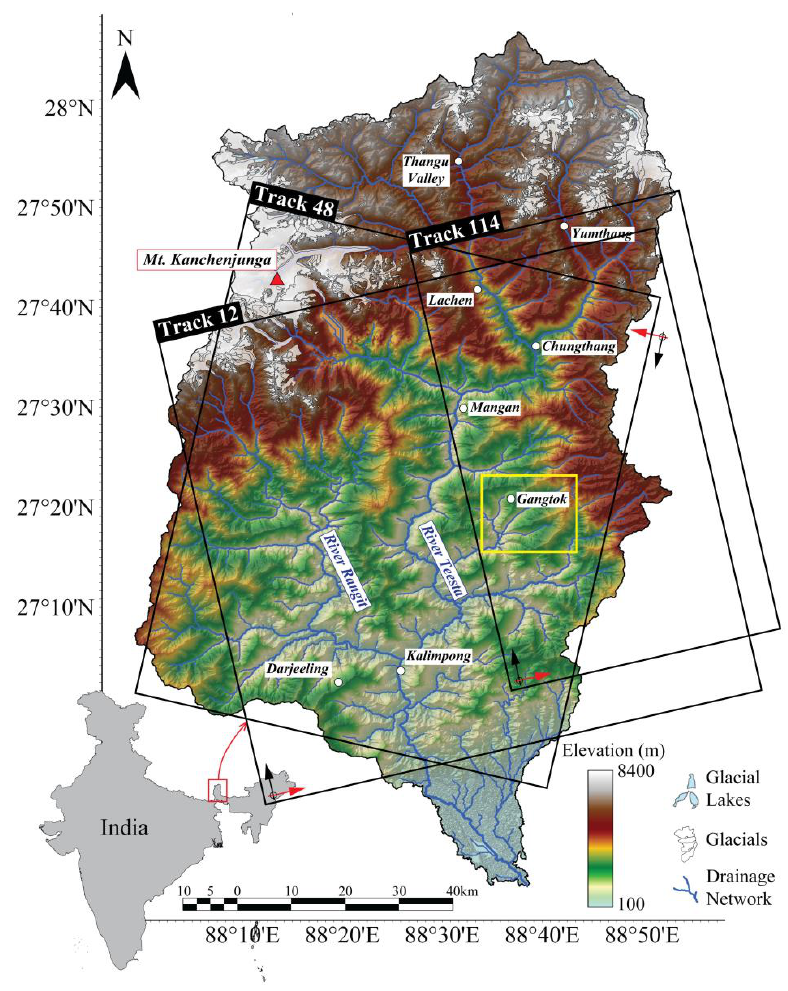
Figure 1. Study area and SAR data coverage. Sentinel 1-A/B SAR data coverage is overlain on the 30 m shaded topography (SRTM-1) with the drainage system. Rectangles labelled with track numbers indicate the coverage of the IW SAR images. Red and black arrows indicate the satellite’s LOS look and flight directions, respectively. The study area outlined by the yellow rectangle is the main area of interest of this study. The glaciers of the Sikkim region were obtained from the GLIMS (Global Land Ice Measurement from Space) database ([20] based on [21]).